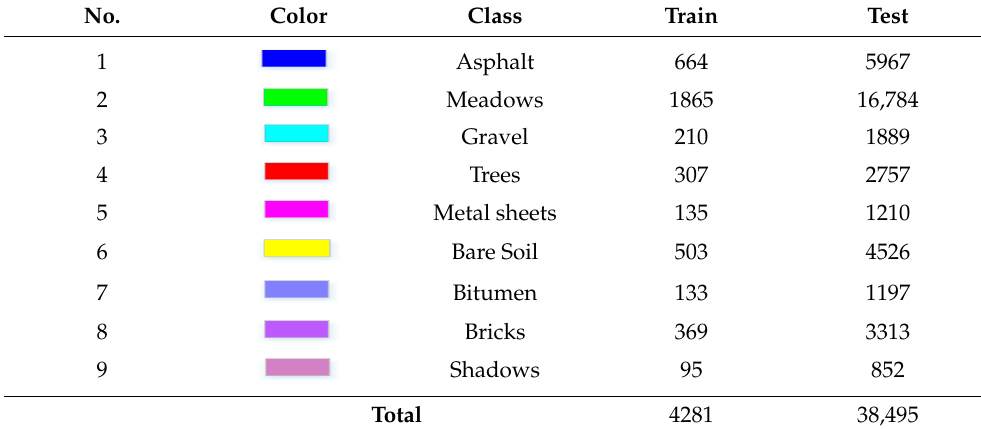
Table 1. Number of training and test samples of UP dataset.